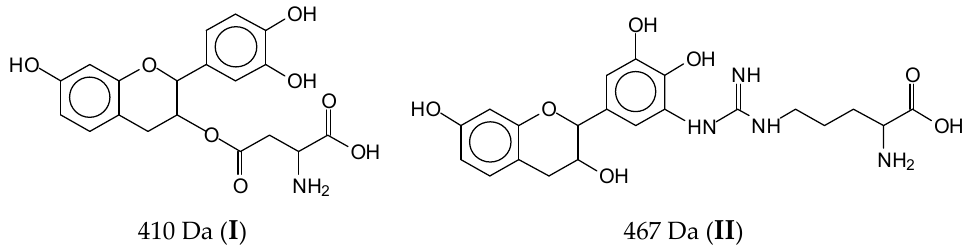
Figure 4. Species identified ( I and II ) indicating the two ways of reacting of protein amino acids with flavonoid tannin